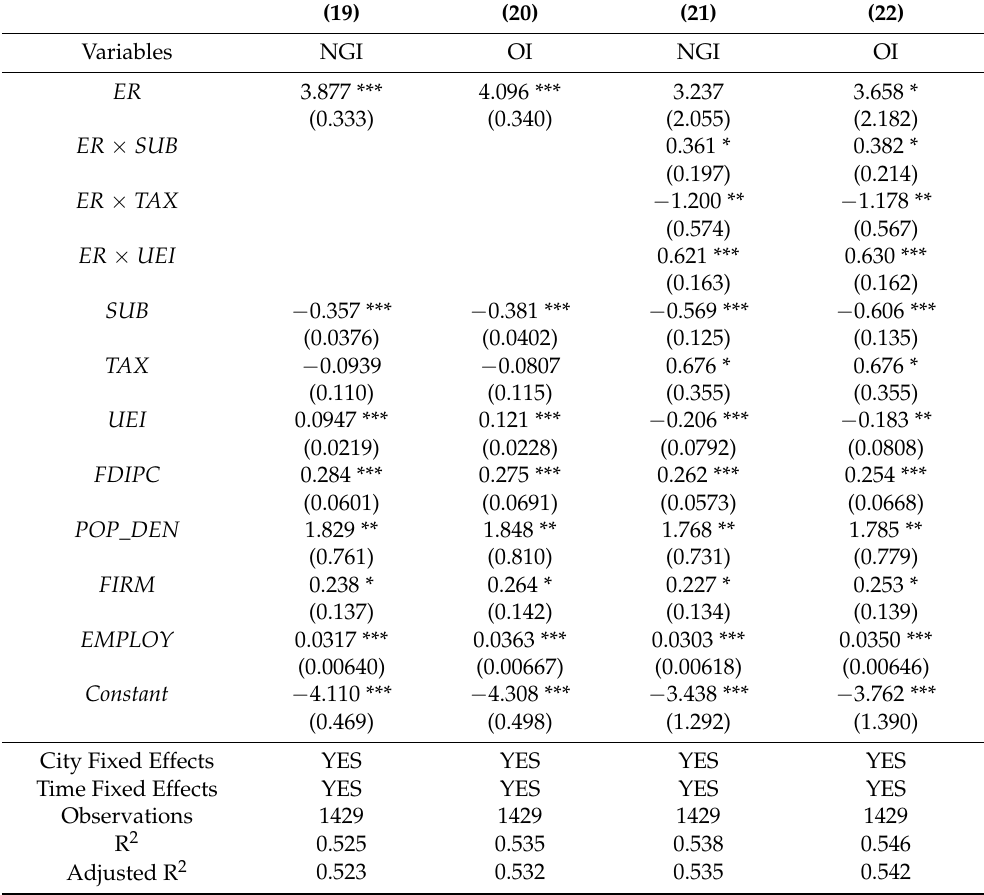
Table 5. Robustness checks by re-estimating the replaced dependent